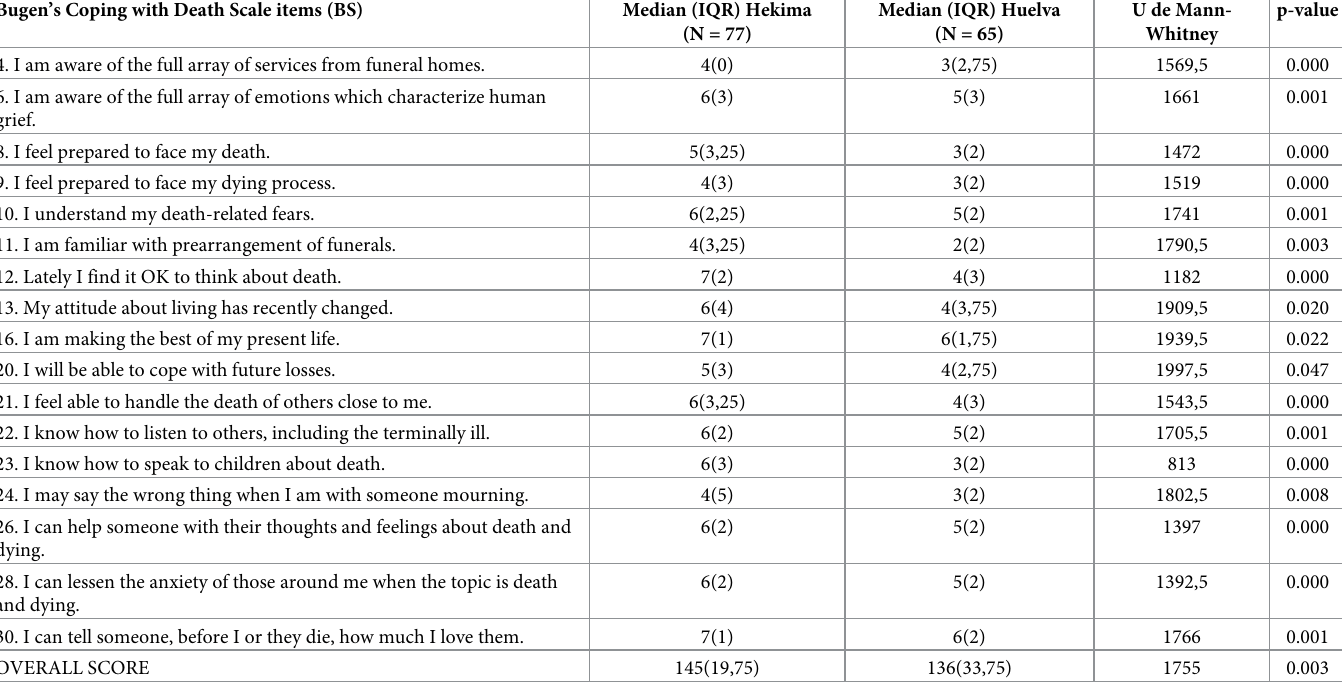
Table 3. P-values pertaining to median comparisons of items found to differ significantly between Huelva and Hekima. Bugen’s Coping with Death Scale items